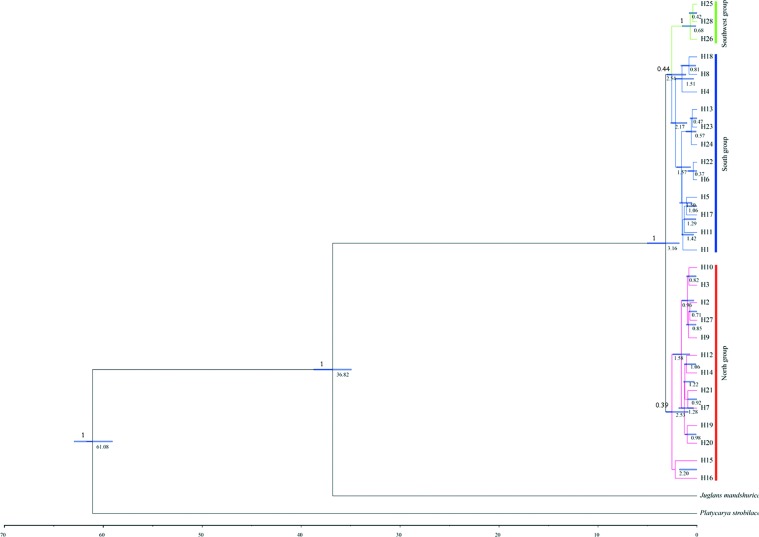
Divergence time of Pterocarya stenoptera based on chloroplast DNA (cpDNA) haplotypes estimated with BEAST. Blue bars indicate the 95% credibility intervals of divergence times. The time of divergence of all nodes are showed below branches, and posterior probabilities are given above the main branches.